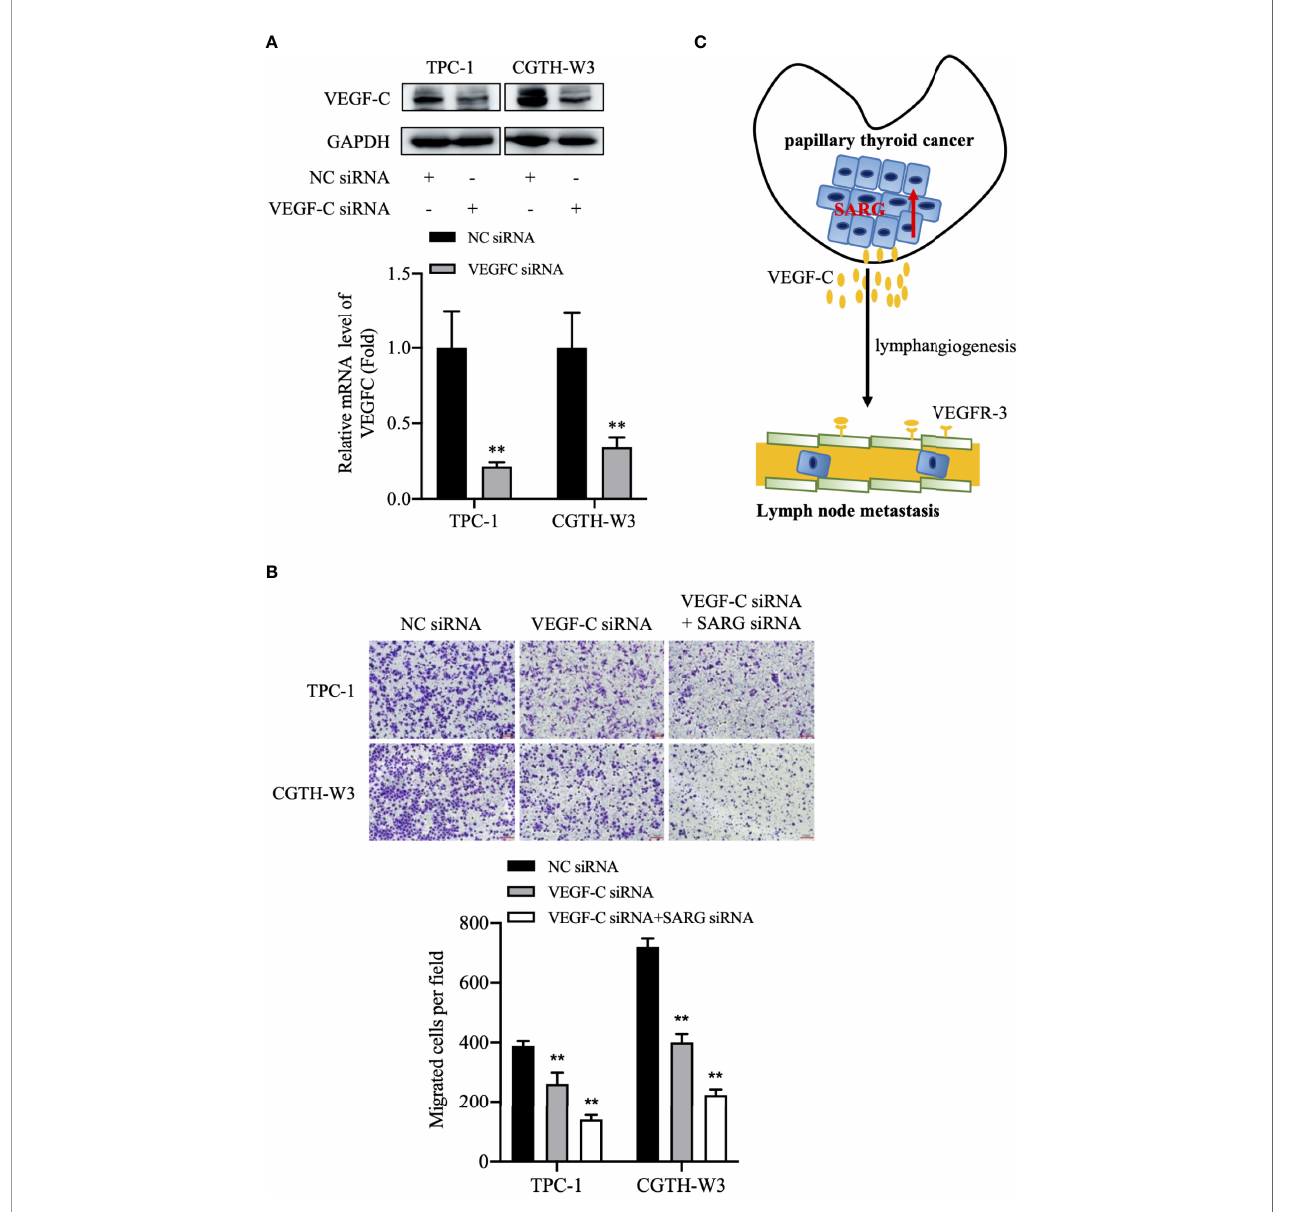
FIGURE 9 | The putative model of lymphatic metastasis mediated by SARG in PTC. (A) VEGF-C protein expression in TPC-1 and CGTH-W3 cells was signi fi cantly decreased after being transfected with VEGF-C siRNA. GAPDH was used as a loading control, whereas NC siRNA was used as the negative control. (B) Knocking down VEGF-C promoted then anti-migration activity of SARG-siRNA in PTC cells. ** p<0.01 compared with NC-siRNA. C, SARG was upregulated in PTC and could upregulate VEGF-C expression in PTC cells, then promoted lymphangiogenesis and lymph node metastasis. PTC, papillary thyroid carcinoma; SARG, speci fi cally androgen-regulated gene; VEGF-C, vascular endothelial growth factor